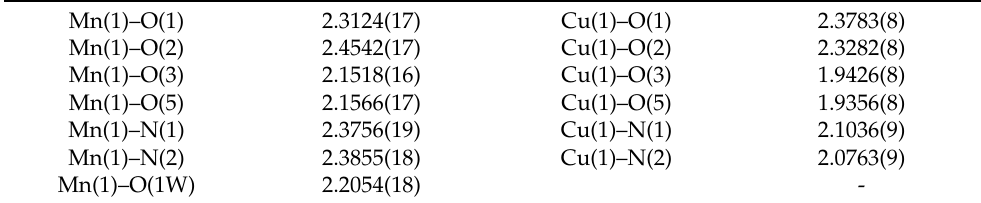
Figure 1. X-ray crystal structures of the [Mn( t O2DO2A )(H 2 O)] ( a ) and [Cu( t O2DO2A )] ( b ) complexes. Non-coordinated water molecules and hydrogen atoms bonded to C atoms are omitted for simplicity. The Oak Ridge Thermal Ellipsoid Plots (ORTEP) are at the 30% probability level. Table 1. Bond distances of the metal coordination environments in [Mn( t O2DO2A )(H 2 O)] and [Cu( t O2DO2A )] complexes obtained from X-ray diffraction